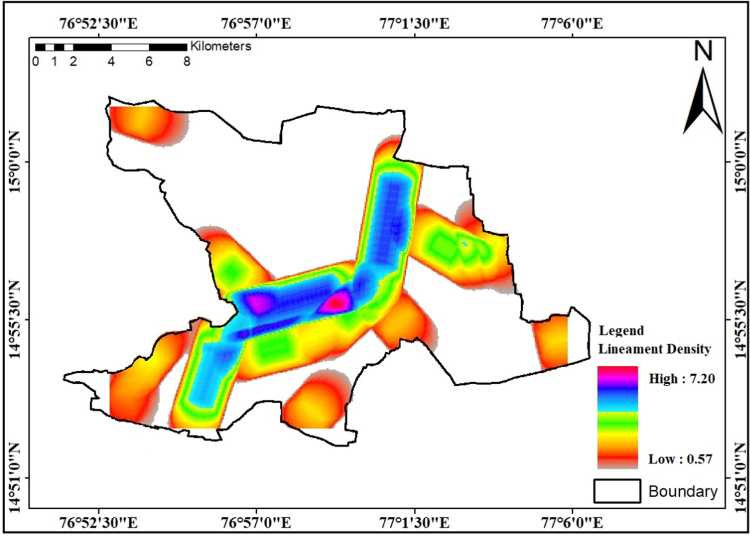
Lineament density map of the study area in km/km2.